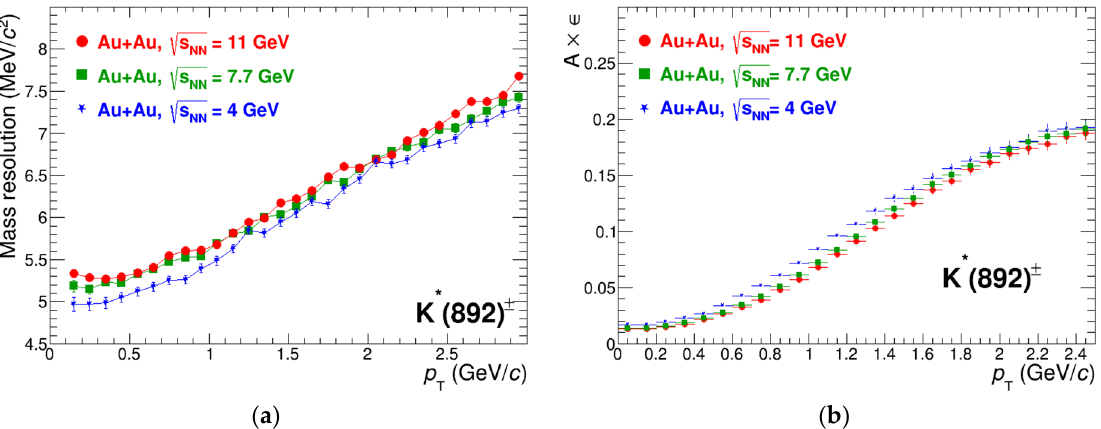
Figure 4. The detector mass resolution ( a ) and efficiency of reconstruction ( b ) as a function of transverse momentum for K*(892) ± → π ± 𝐾 𝑠0 decays in Au+Au collisions at different energies.